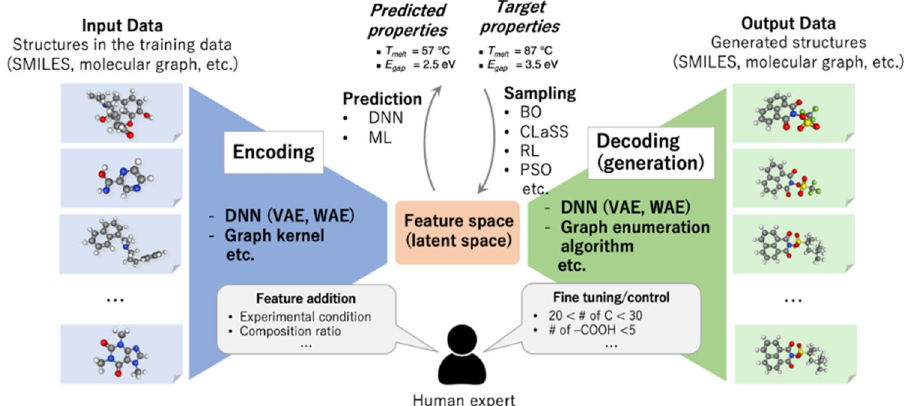
Fig. 5 Using generative models to explore chemical space. A conceptual framework of molecular generative model. Each component; data formatting, encoding, prediction, sampling, and decoding are dependent on an approach (e.g. deep generative model, graph theory approach,